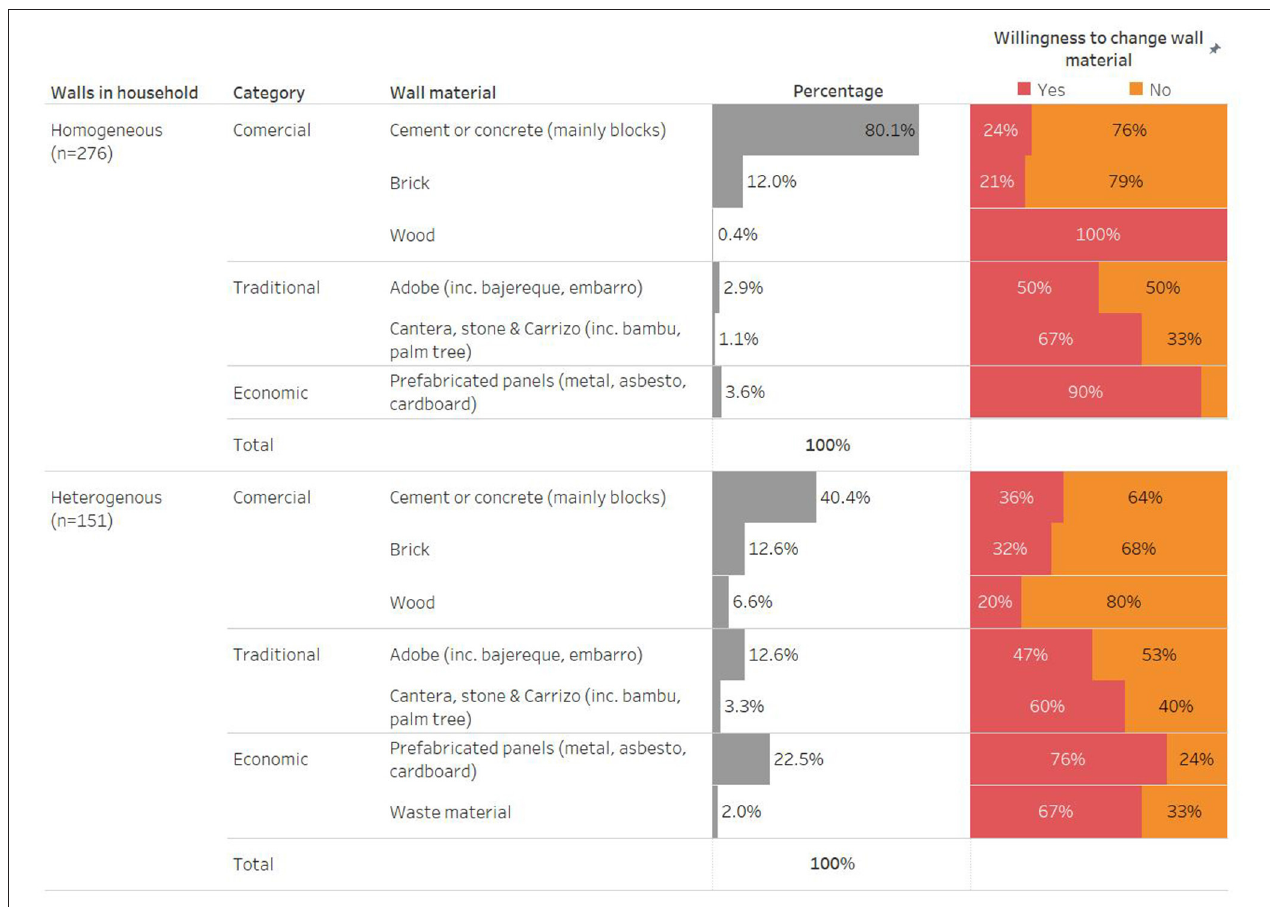
FIGURE 1 | Wall materials and willingness to change in ZMVO